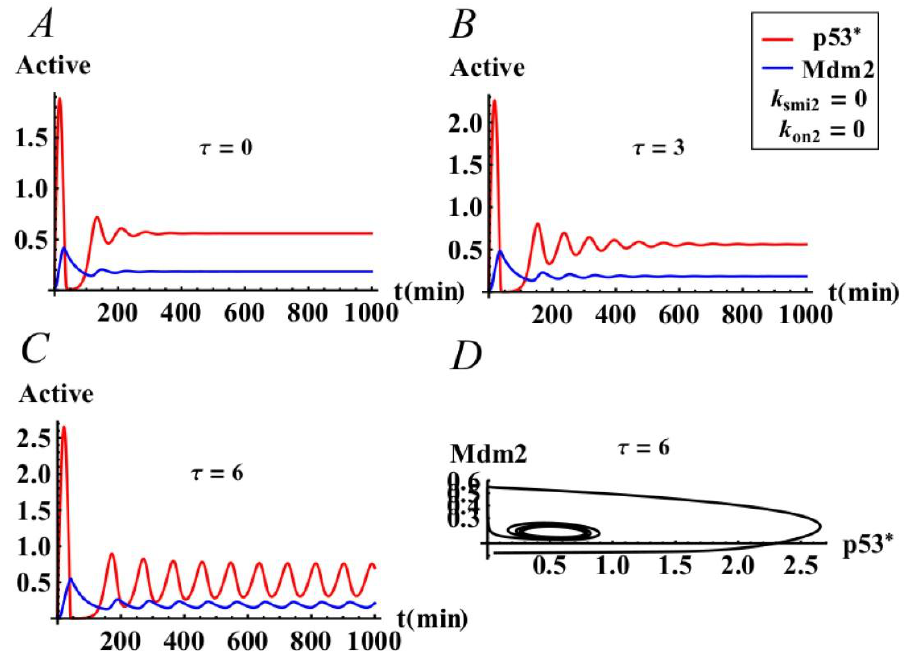
Figure 5. The e ff ects of time delay τ on the p53-Mdm2 system of model (1) when there is no expression of miR34-a. ( A ) The positive equilibrium is asymptotically stable when τ = 0. ( B ) The positive equilibrium is asymptotically stable when τ = 3 < τ 0 = 5.1038. ( C , D ) The positive equilibrium is unstable when = τ = 6 > τ 0